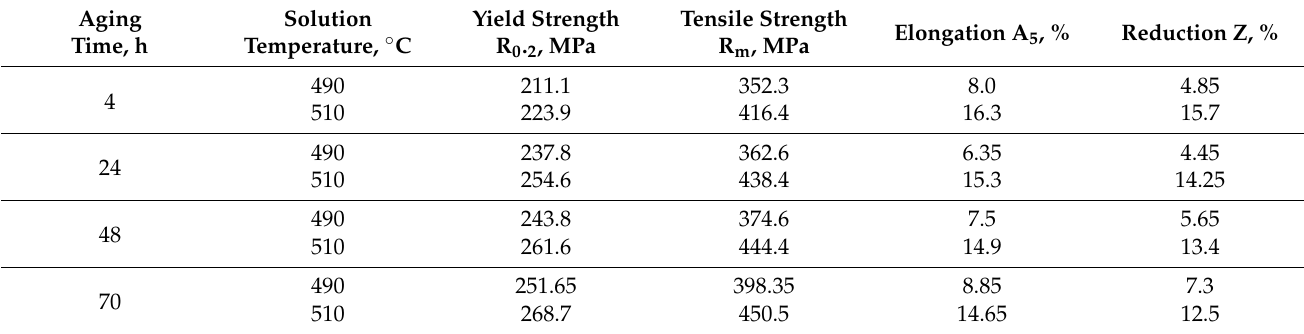
Figure 20. Effect of solution heat treatment and aging temperature on the rate of increase in hardness of the 2017A alloy during natural and artificial aging. Table 7. Effect of solution heat treatment temperature and natural aging time on the strength and plastic properties of the 2017Aaluminium